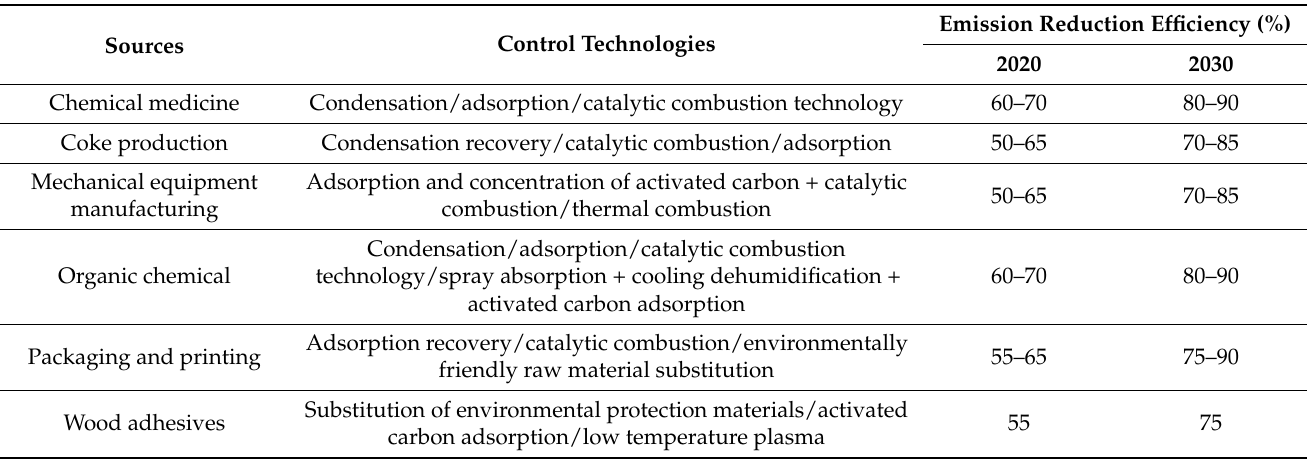
Table 5. Detailed parameters of the control measures of various industrial